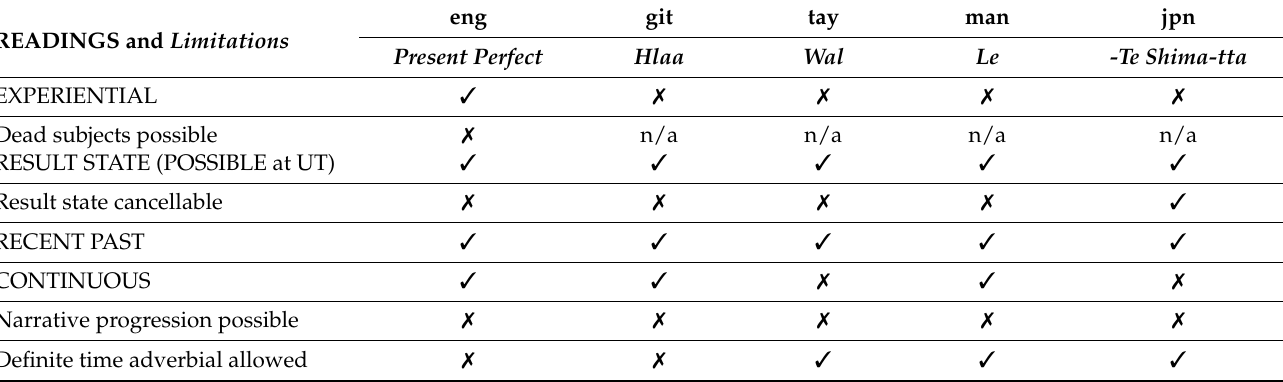
Table 4. Resultative